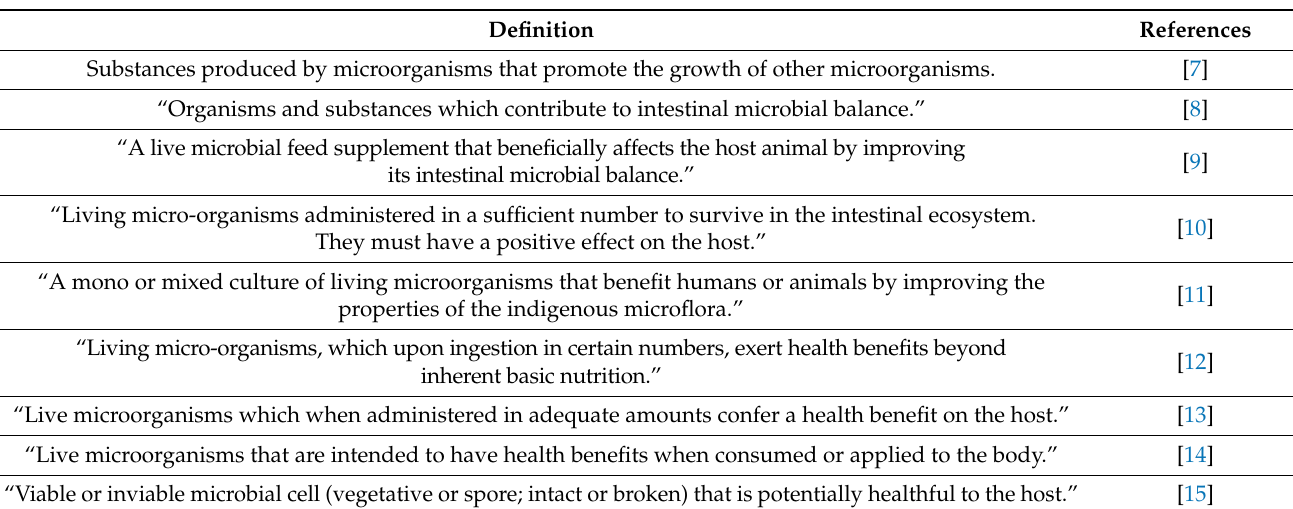
Table 1. Evolution of the lato sensu meaning of probiotic.